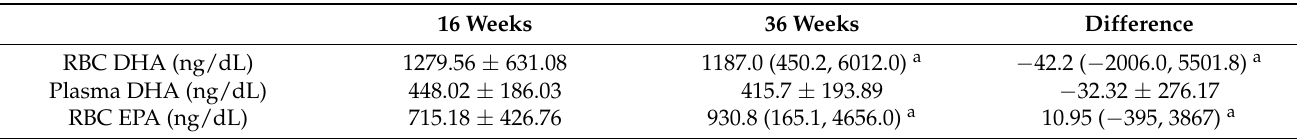
Table 3. Maternal blood EPA and DHA concentrations at 16 and 36 weeks gestation and the difference from early to late pregnancy.